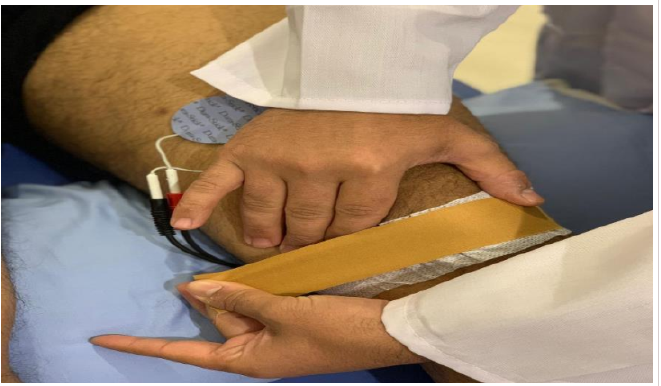
Figure 3. Application of McConnell